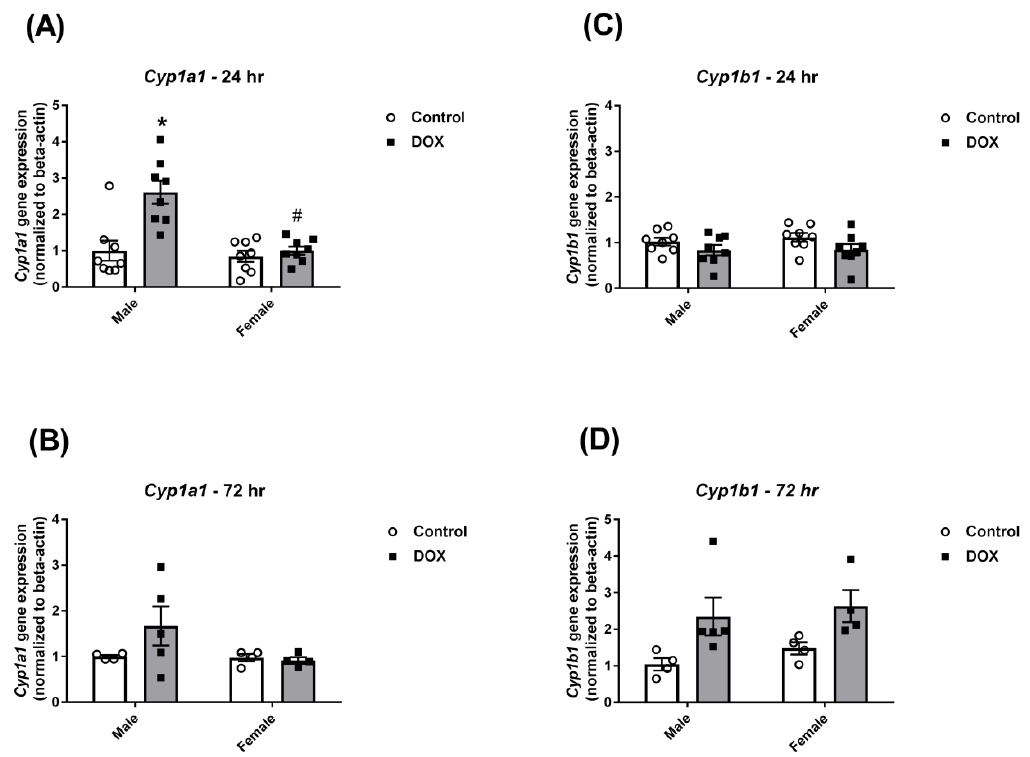
Figure 3. Effect of DOX treatment on the gene expression of the Cyp1 family in the liver. Livers were